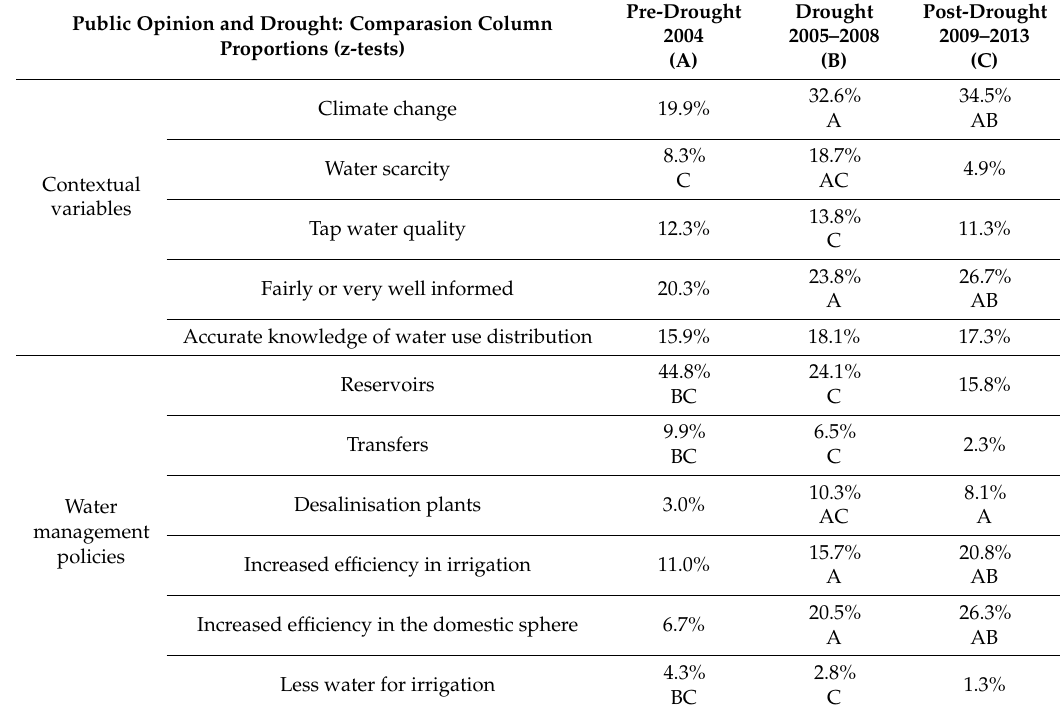
Table 1. Comparison of results from the three periods. Source: Authors’ own after EBA 2001–2013